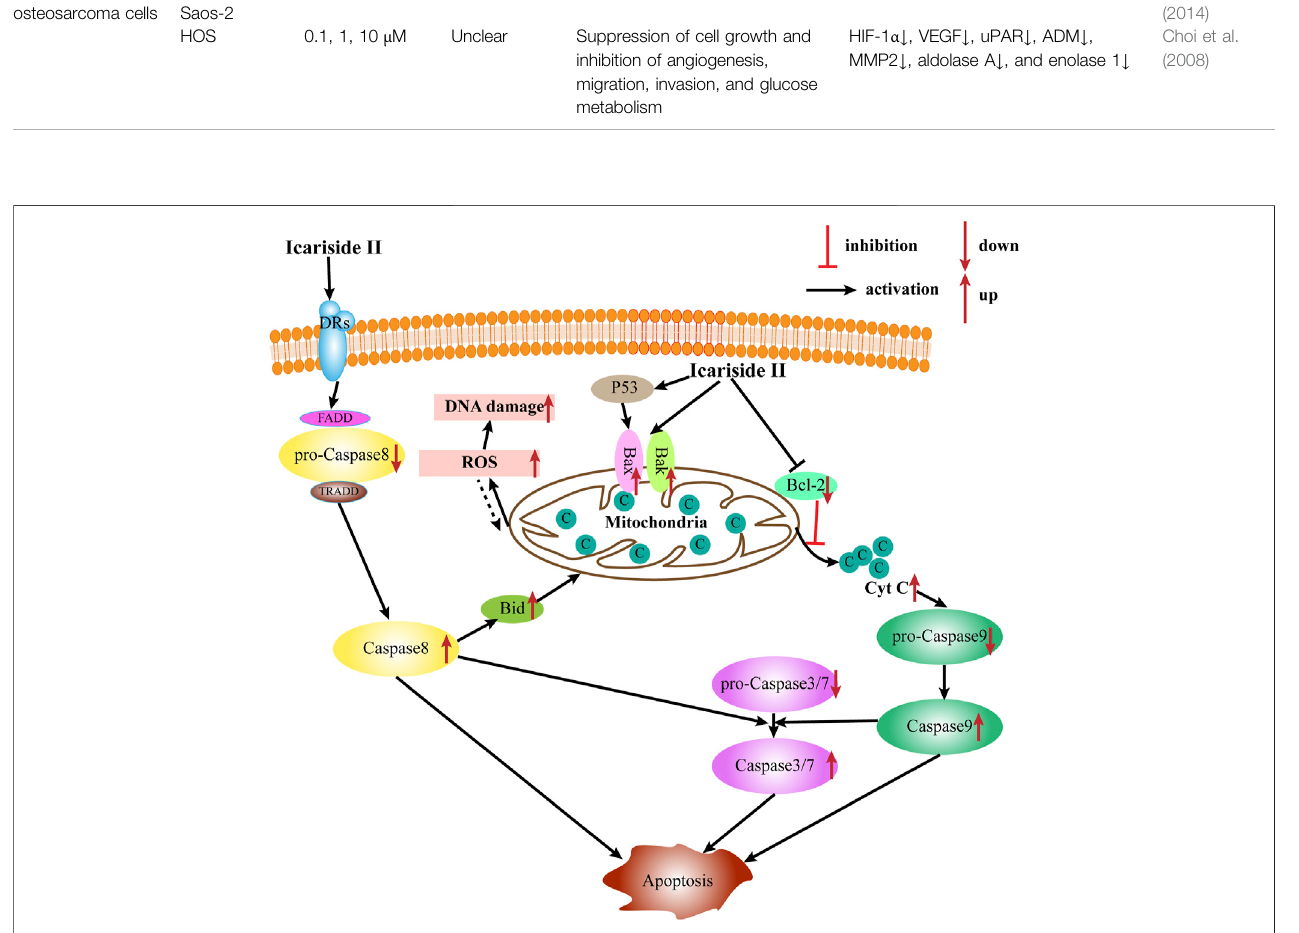
FIGURE 2 | Apoptosis induction by Icariside II intrinsic and extrinsic